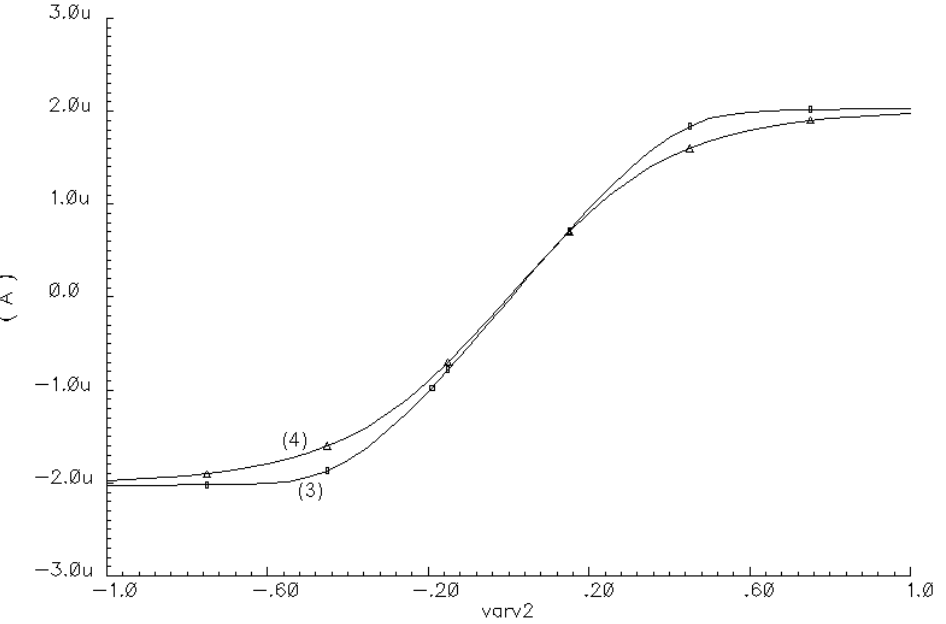
Figure 2. Approximation of Equation (3) by means of Equation